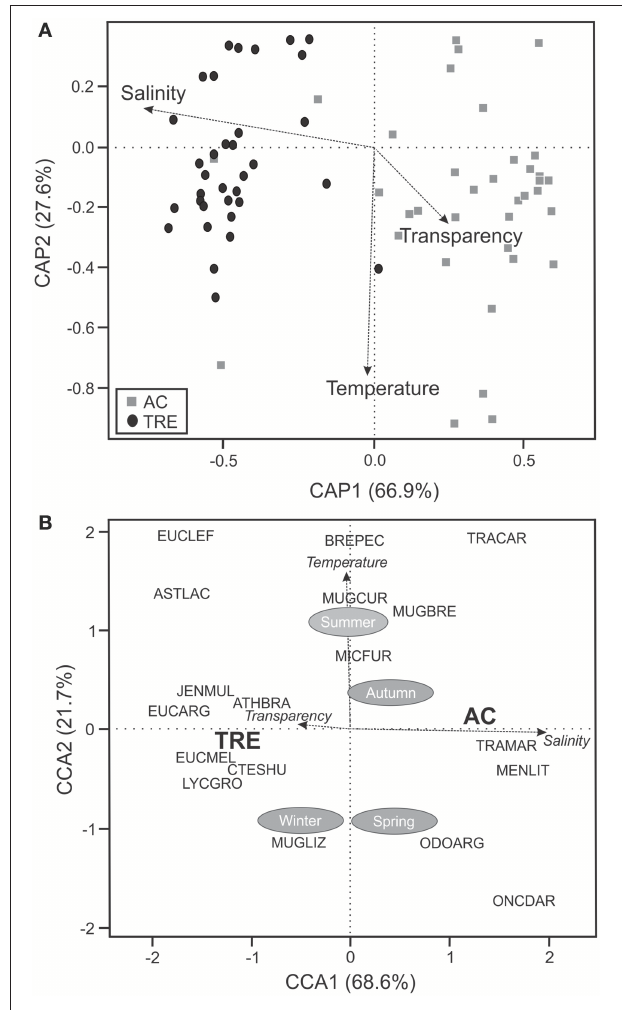
FIGURE 2 | (A) Canonic coordinate analysis principal (CAP) based on dominant species and (B) canonical correlation analysis (CCA) relating the dominant species to the environmental variables and seasons. TRE, Tramandaí River estuary; AC, marine adjacent coastal area.